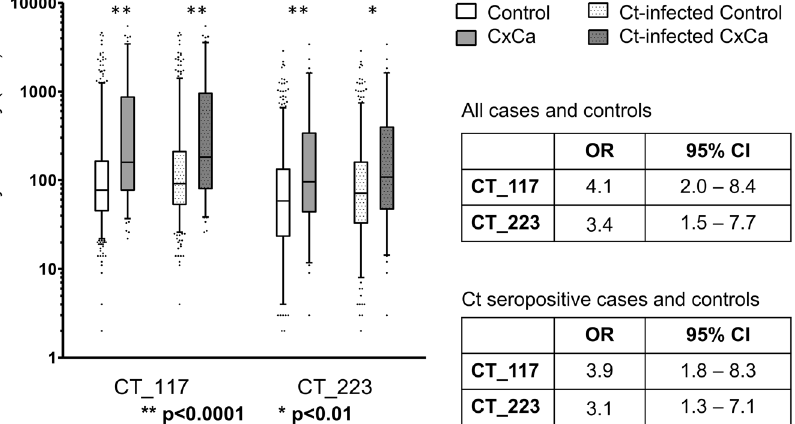
Figure 7. Increased antibody reactivities and risk of CxCa for serum antibodies to Ct antigens CT_117 and CT_223. Seropositivity for each of the two proteins was significantly associated with elevated CxCa risk when comparing all CxCa cases and all controls as well as when restricting the risk assessment to Ct-infected individuals among both cases and controls. OR, odds ratio; CI, confidence